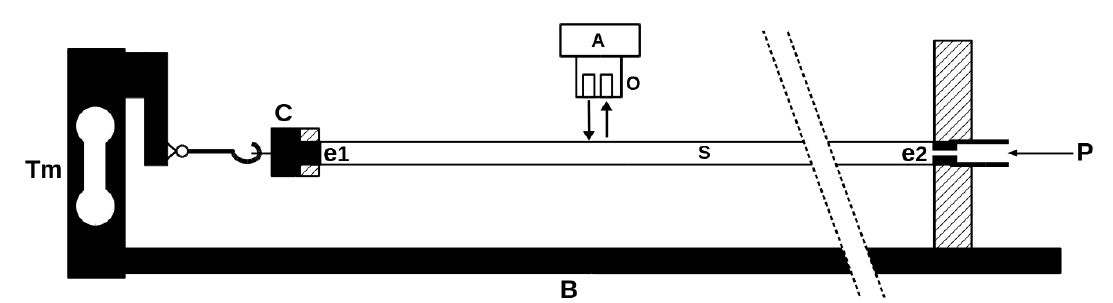
Figure 1. The test bench scheme: B, rigid basement; Tm, tensometer; e1, closed end plug; e2, end plug with a gas supply channel; C, end cap with a seal; P, pressure supply; S, straw; O, optical coupler; A,